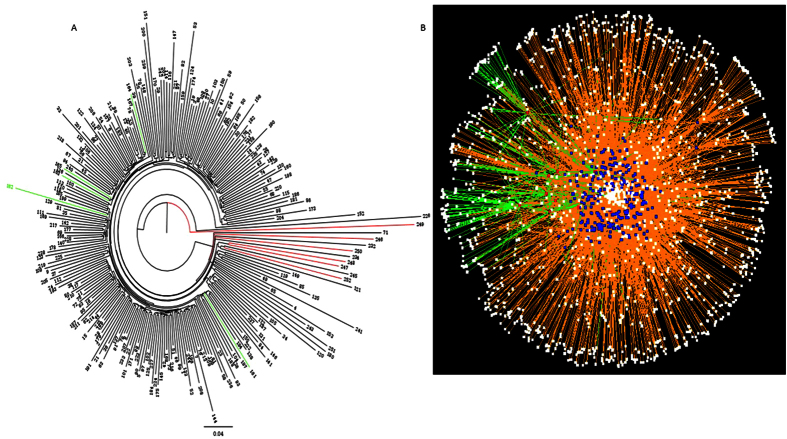
Clustering of chickens based on blood microbiota.(a) Hierarchical clustering of healthy vs BCO chickens based on blood microbiota. Phylogenetic tree was generated using FigTree software V1.3.1 with weighted UniFrac metric using the data before normalization. Green and red lines represent BCO chickens of 41 and 49 day old chickens, respectively. Black lines are healthy chickens. Number at the end of line shows the ID of chicken sample. (b) Bacterial network of chicken blood microbiota produced using Cytoscape software V3.2.1. Red, blue and white nodes represent BCO chickens, healthy chickens and OTUs, respectively. Green edge is the network of BCO chickens and orange edge is that of healthy chickens.